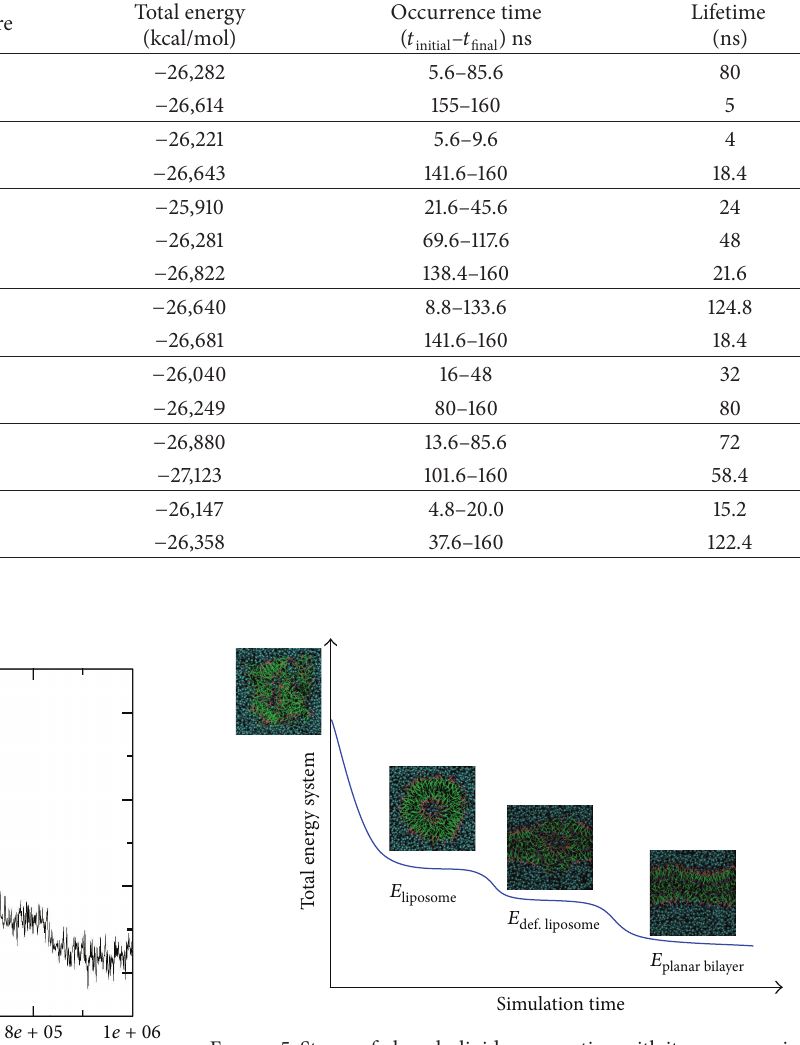
Figure 5: Stages of phospholipids aggregation with its accompanied changes of total energy